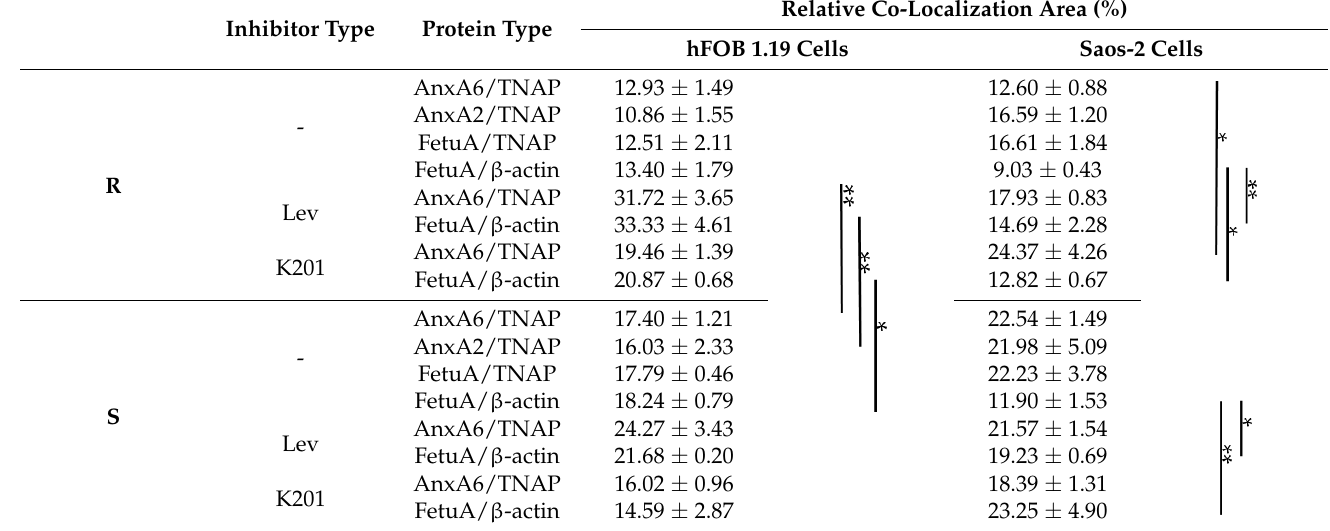
Table 2. Relative co-localization area calculated for AnxA6, AnxA2 or FetuA vs. TNAP or β -actin in hFOB 1.19 or Saos-2 cells in resting conditions (R) or after stimulation with AA and β -GP (S). Data are means ± s.e., n = 3 measurements of three independent experiments (* p < 0.05 and ** p < 0.01).